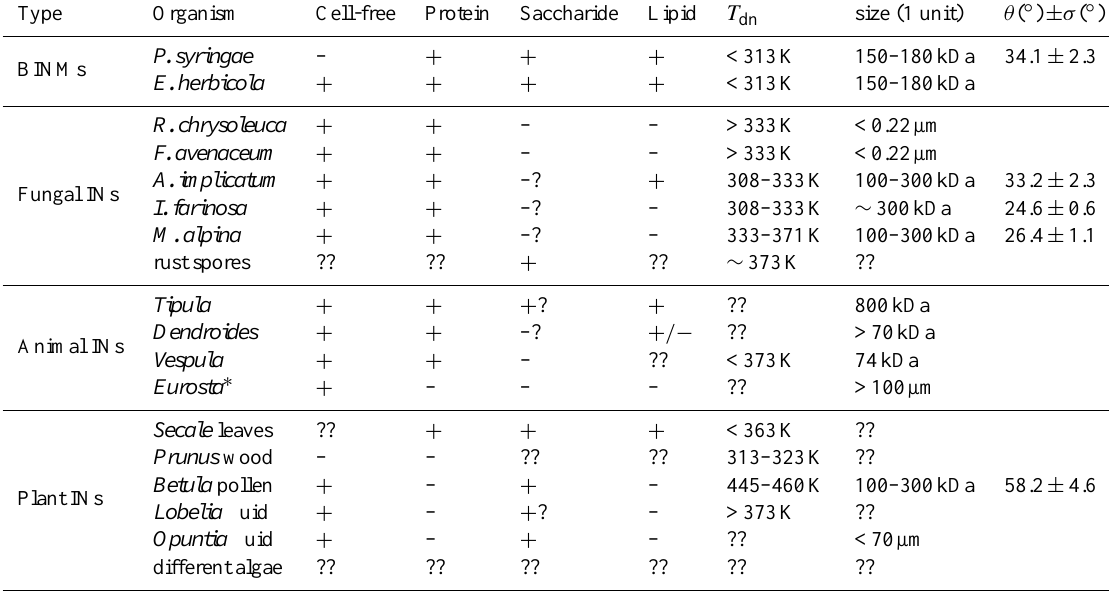
Table 1. Chemical properties of some INs. T dn shows the temperature above which they are denatured. A question mark indicates uncertainty. See Sect. 4.1 for the sources of these data. θ [ ◦ ] ± σ [ ◦ ] are the calculated contact angle distribution according to the soccer ball model. Type